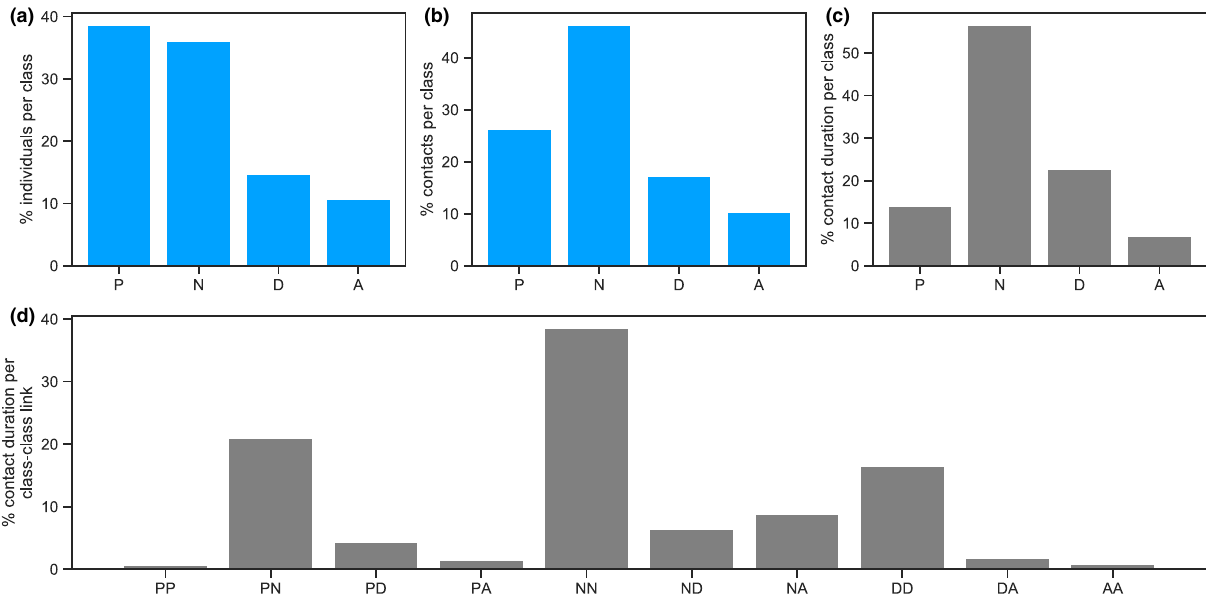
Figure 1. Contacts in the hospital ward. Percentage of participating individuals ( a ), of contacts ( b ), and of contact duration ( c ) by class of individuals [patients (P), nurses (N), doctors (D), administrative personnel (A)]. ( d ) Percentage of contact duration between classes of